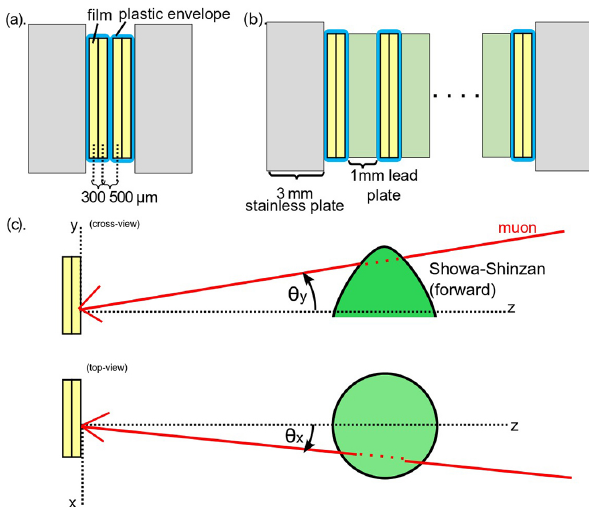
Fig. 3. Schematic cross views of two types of emulsion detec- tors. (a) Quartet detector: emulsion films, packed in twos in plas- tic light-shielding envelopes stacked between 3mm-thick stainless steel plates to ensure planarity. (b) ECC detector: ten envelopes and nine 1mm-thick lead plates interleaved between 3mm-thick stain- less steel plates. (c) Emulsion coordinate system for identifying the position and direction of particles.